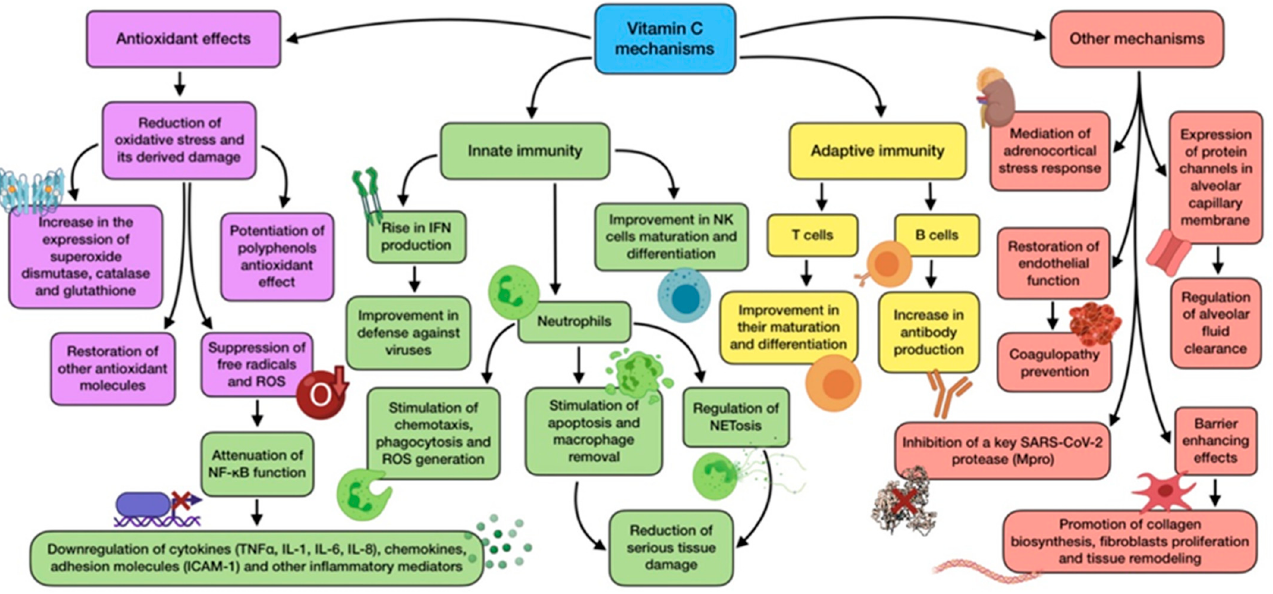
Figure 3. Summary of the main vitamin C mechanisms of action.